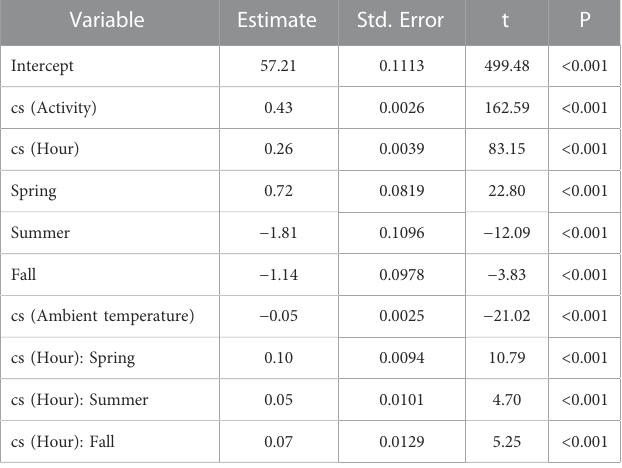
TABLE 5 Summary of the best- fi t model using GAMLSS and family distribution Johnson ’ s SU ( JSU ) to assess the importance of covariates for hourly heart rate average (bpm) in six captive scimitar-horned oryx. A generalized R 2 value of 51.5 was calculated using the Rsq function and non-linear effects were fi t using cubic spline ( cs ) function of the gamlss R